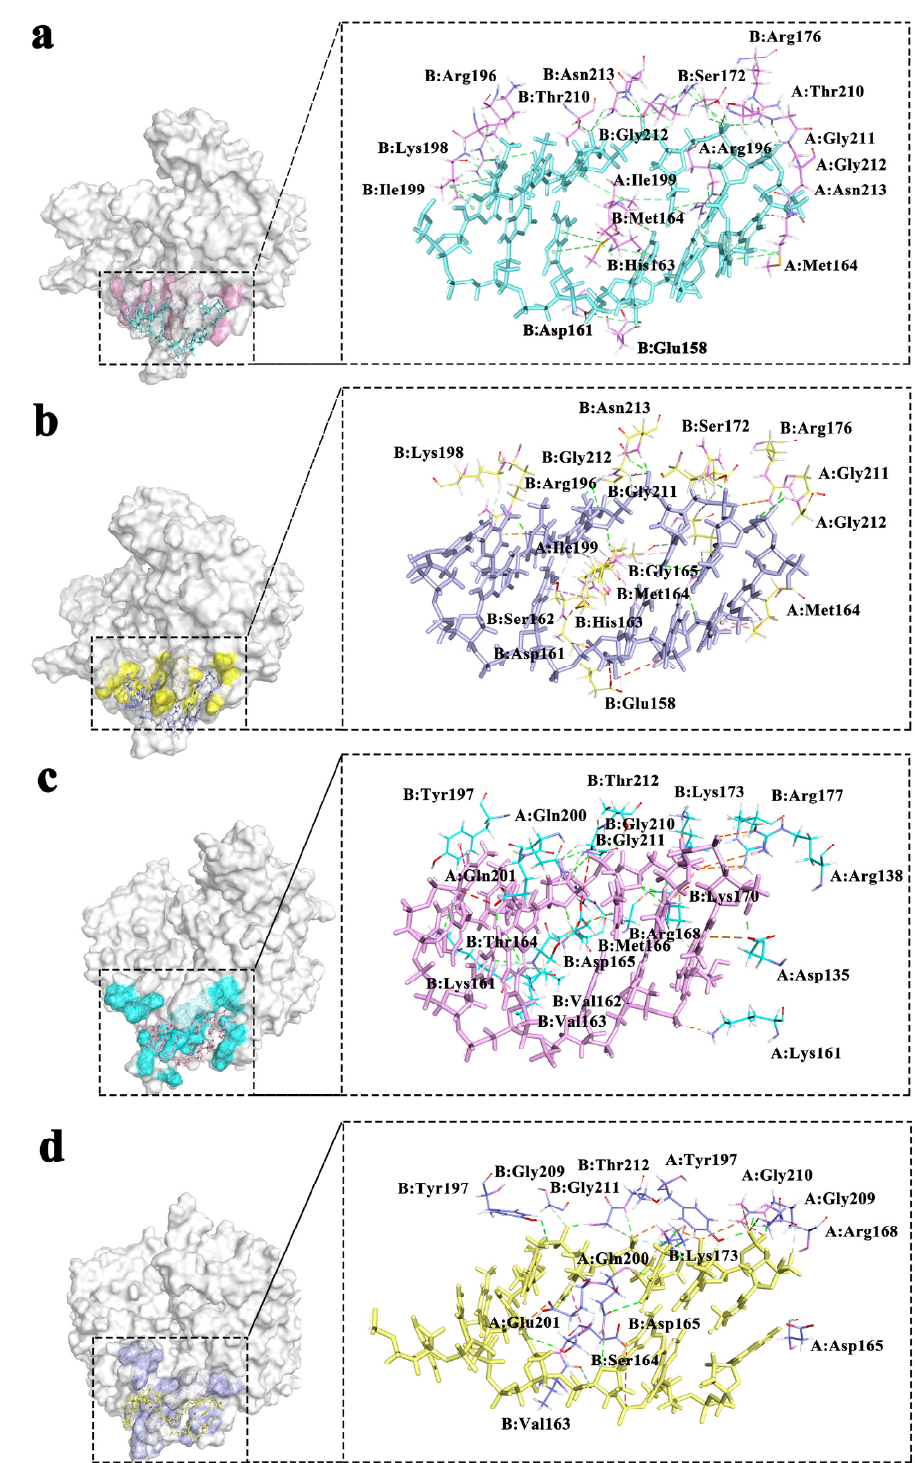
Figure 6. Schematic diagram of DNA binding region ( a ) 298 K RecA; ( b ) 310 K RecA; ( c ) 298 K UvsX; ( d ) 310 K UvsX. (The colors of the dashed lines represent the interactions as shown in Figure 5).